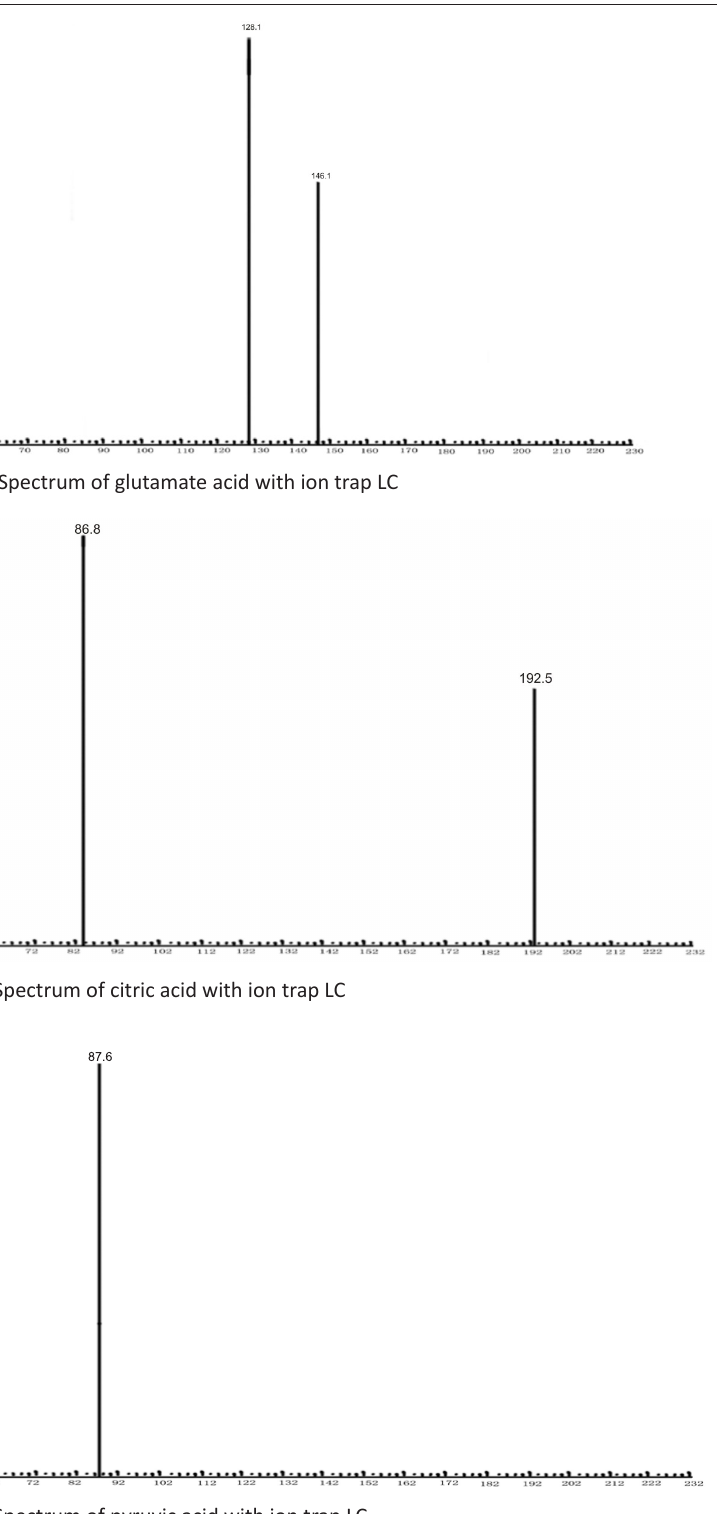
Fig. 4. Spectrum of pyruvic acid with ion trap